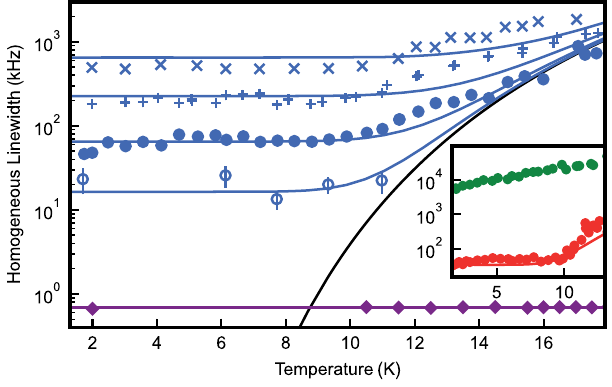
FIG. 5. Temperature dependence. The temperature of the CVD sample is changed with a resistive heater. The lifetime τ of the optically excited state, and thus the lifetime limit 1 = ð 2 πτ Þ (purple data and line) of the homogeneous linewidth, is independent of temperature, as expected for erbium dopants in the absence of nonradiative decay of the optically excited state. In contrast, the homogeneous linewidth shows an increase with temperature. For site A (blue, main panel) and several input powers (different symbols), the rise is well explained by Orbach relaxation of the spin levels (blue fit curves). From the Orbach coefficient, in the absence of power broadening (black), we expect that the lifetime- limited linewidth may be observed below about 8 K. While site B shows similar temperature dependence (red, inset), the other bright site (green, inset) exhibits much broader lines even at 2 K, owing to its smaller CF level